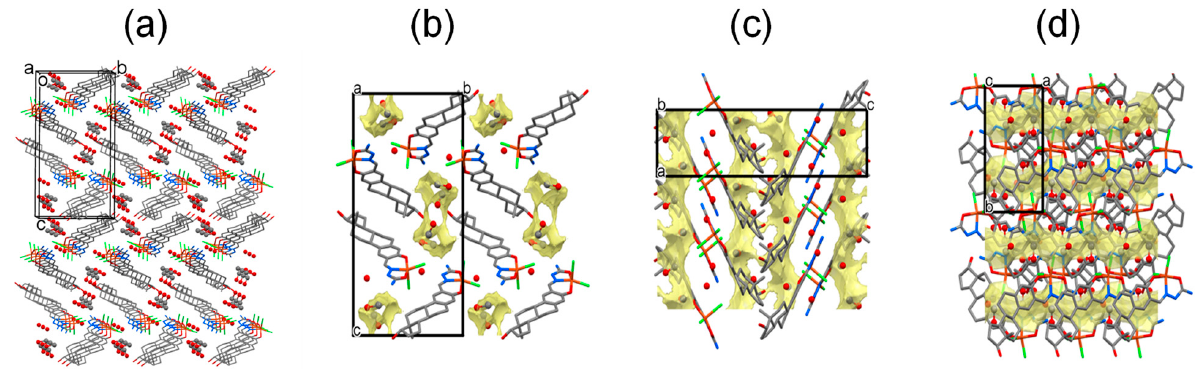
Figure 5. ( a ) Crystal packing of [Cu(HL)Cl 2 ] × H 2 O × 2CH 3 OH complex of estradiol-SC drawn by stick representation and solvate molecules by ball and stick representation (hydrogen atoms are omitted for clarity). ( b ) View from the a crystallographic axis direction, methanol channels are marked with pale yellow, ( c ) view from the b crystallographic axis direction, ( d ) view from the c crystallographic axis